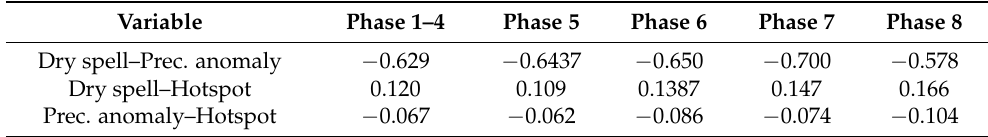
Table 4. Measure of association of each variable pair from 2001 to 2020 of 1st dry season in northern Sumatra.